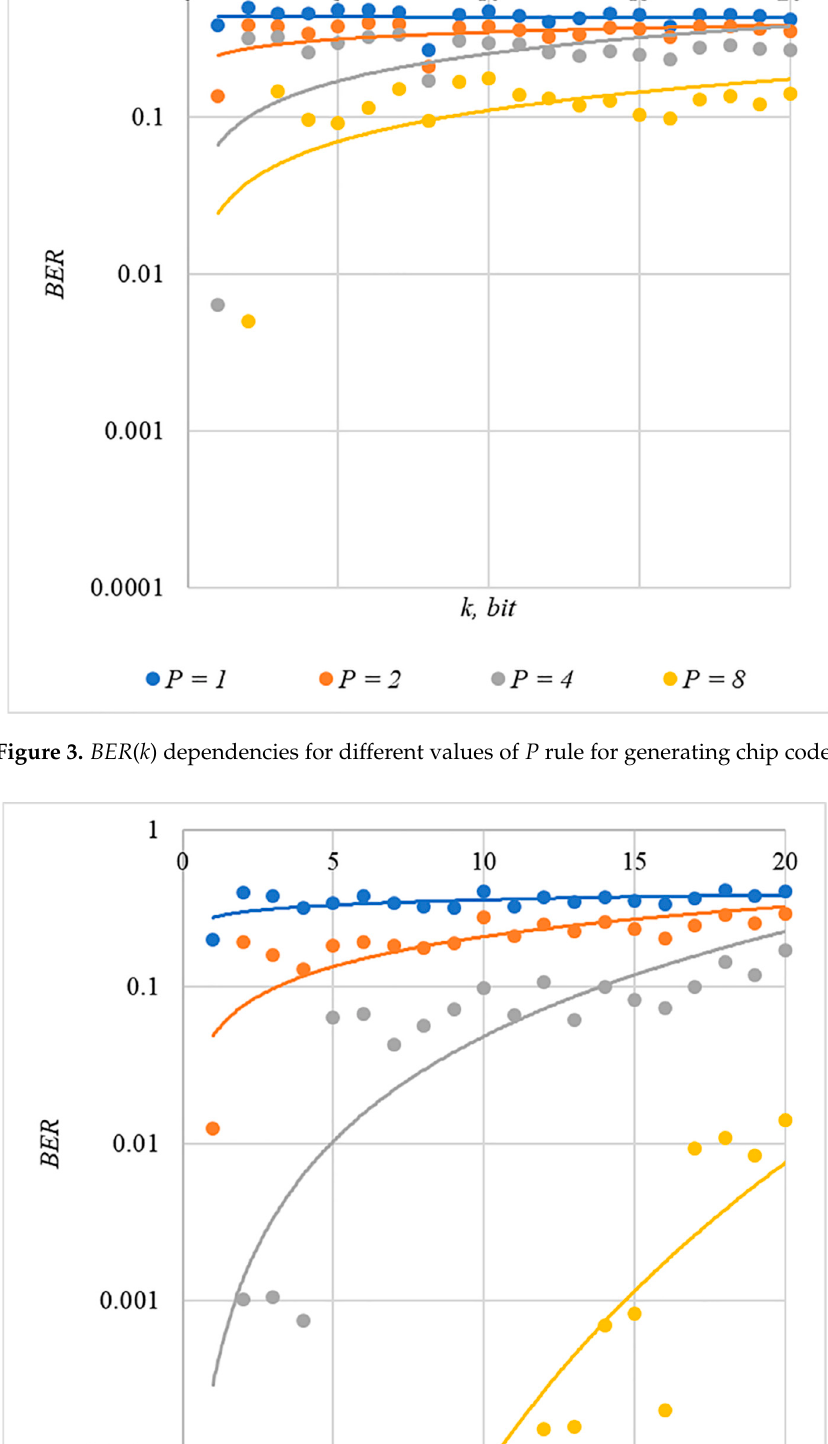
Figure 2. BER ( k ) dependencies for different values of